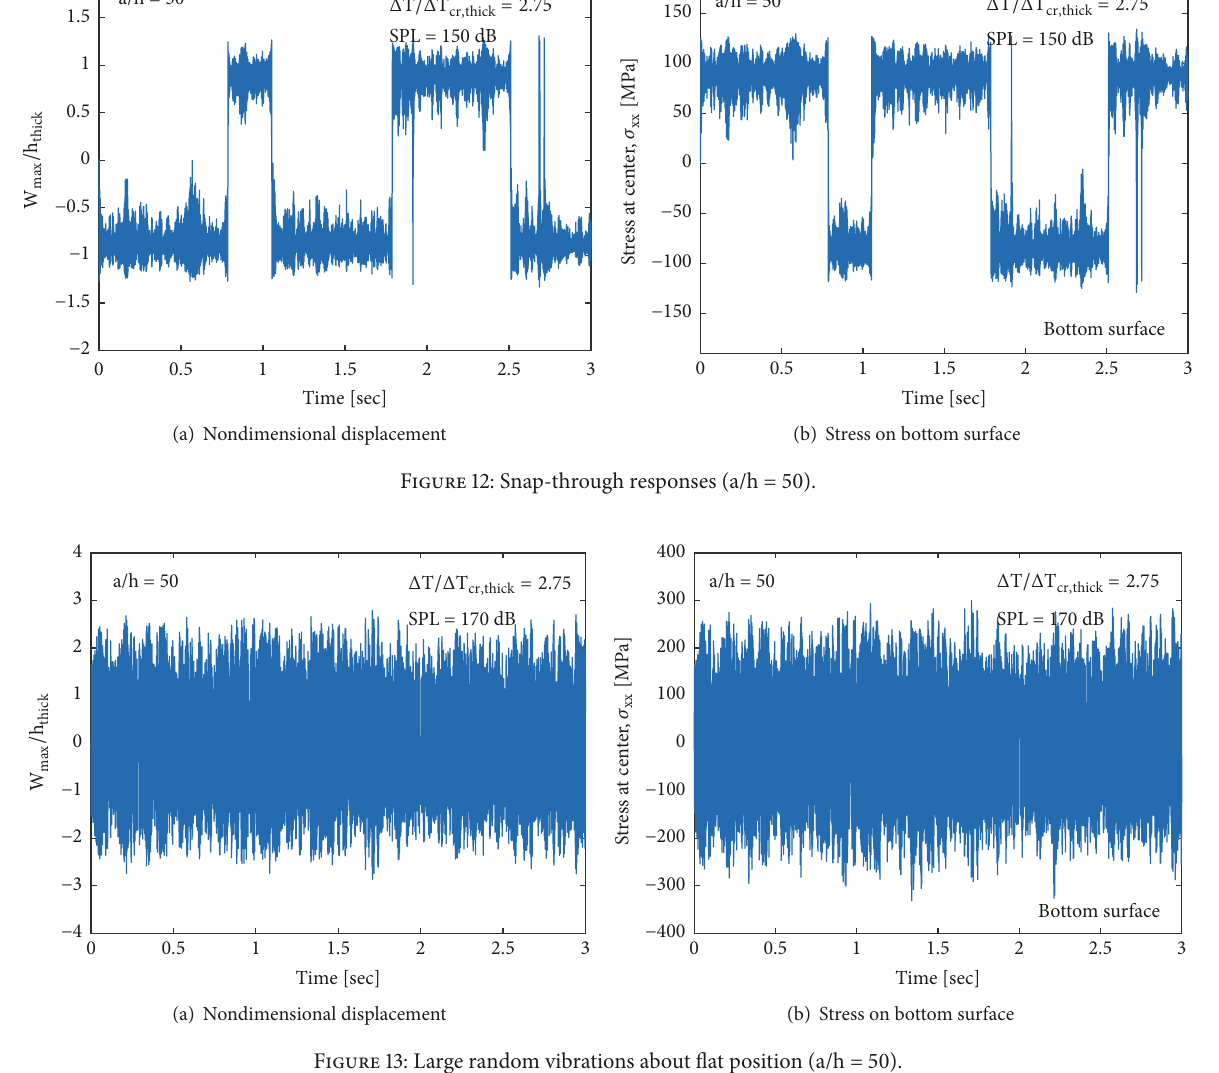
Figure 13: Large random vibrations about flat position (a/h =